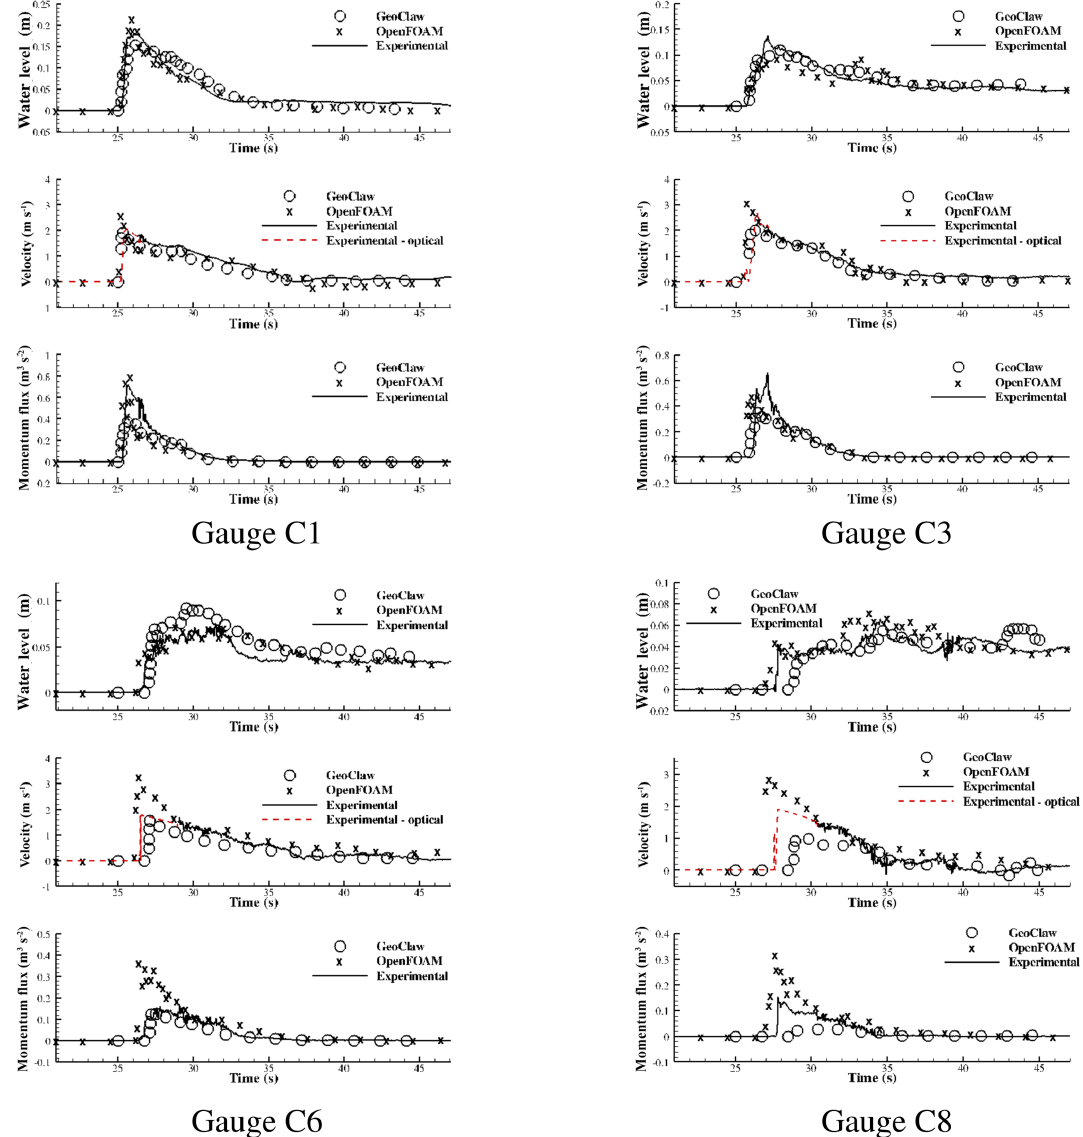
Figure 10. Time histories of surface elevation, cross-shore velocity, and momentum flux at some selected gauges along line